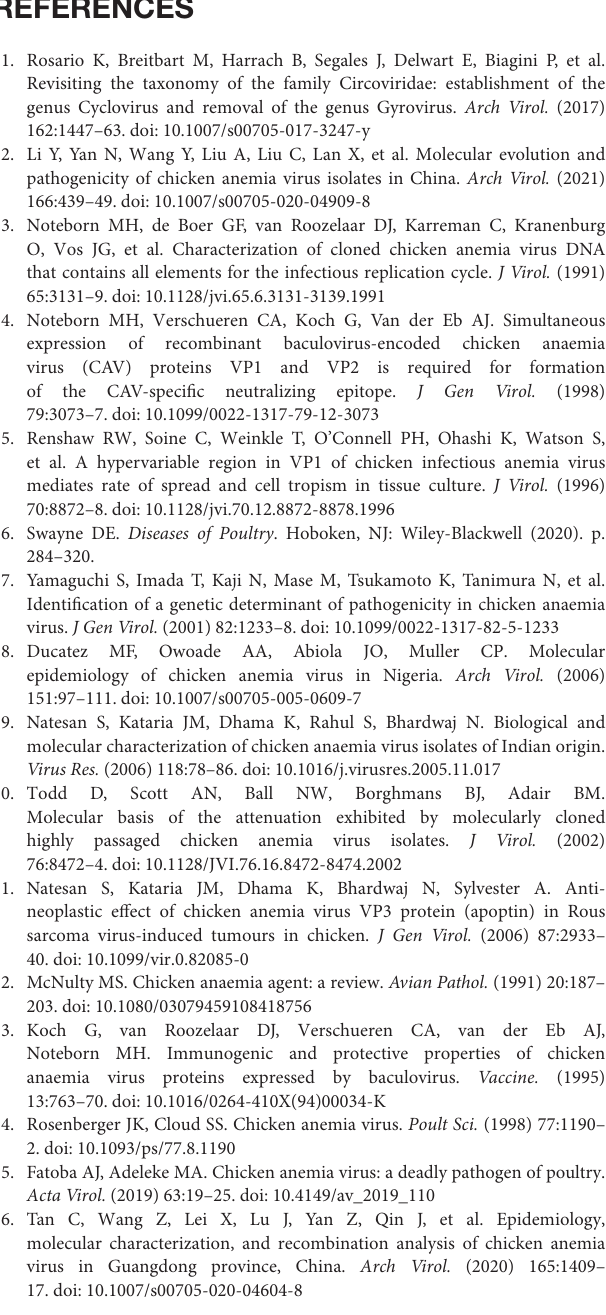
were used for phylogenic analysis by the neighbor-joining method, with phylogenetic distances calculated using MEGA 7.0 software. Bootstrap values obtained from 1,000 replicates are shown at the major nodes. The genogroups are indicated. The strains isolated in this study are indicated by solid dots. Supplementary Table 1 | Details about the chicken anemia virus (CAV) reference strains from GenBank. Supplementary Table 2 | CAV viral load in various tissues of chickens in the infection